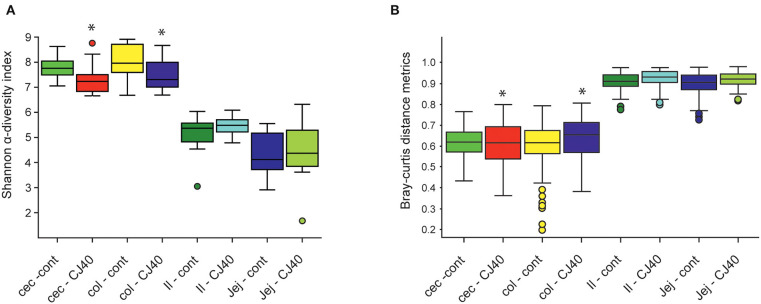
Effects of the diet containing 40% yeast protein on (A) α-diversity, (B) β-beta diversity of microbial populations in ileum, jejunum, cecum, and colon samples. The statistically significant differences were observed for α-diversity metrics for cecum (Kruskal–Wallis: H = 4.32, p = 0.04, and q = 0.06) and colon (Kruskal–Wallis: H = 3.85, p = 0.05, q = 0.07) samples; β-beta diversity metrics for cecum (PERMANOVA: pseudo—F = 2.1, p = 0.03, and q = 0.04) and colon (PERMANOVA: pseudo—F = 1.9, p = 0.05, and q = 0.06) samples. Asterisk represent significant difference. Inclusion of 40% yeast protein had no statistically significant impact on α-diversity metrics neither for ileum (Kruskal–Wallis: H = 0.32, p = 0.57, and q = 0.59) and jejunum (Kruskal–Wallis: H = 0.39, p = 0.53, and q = 0.58) samples nor for β-beta diversity metrics for ileum (PERMANOVA: pseudo—F = 0.52, p = 0.901, and q = 0.90) and jejunum (PERMANOVA: pseudo—F = 0.52, p = 0.834, and q = 0.86) samples. n = 12 per group.